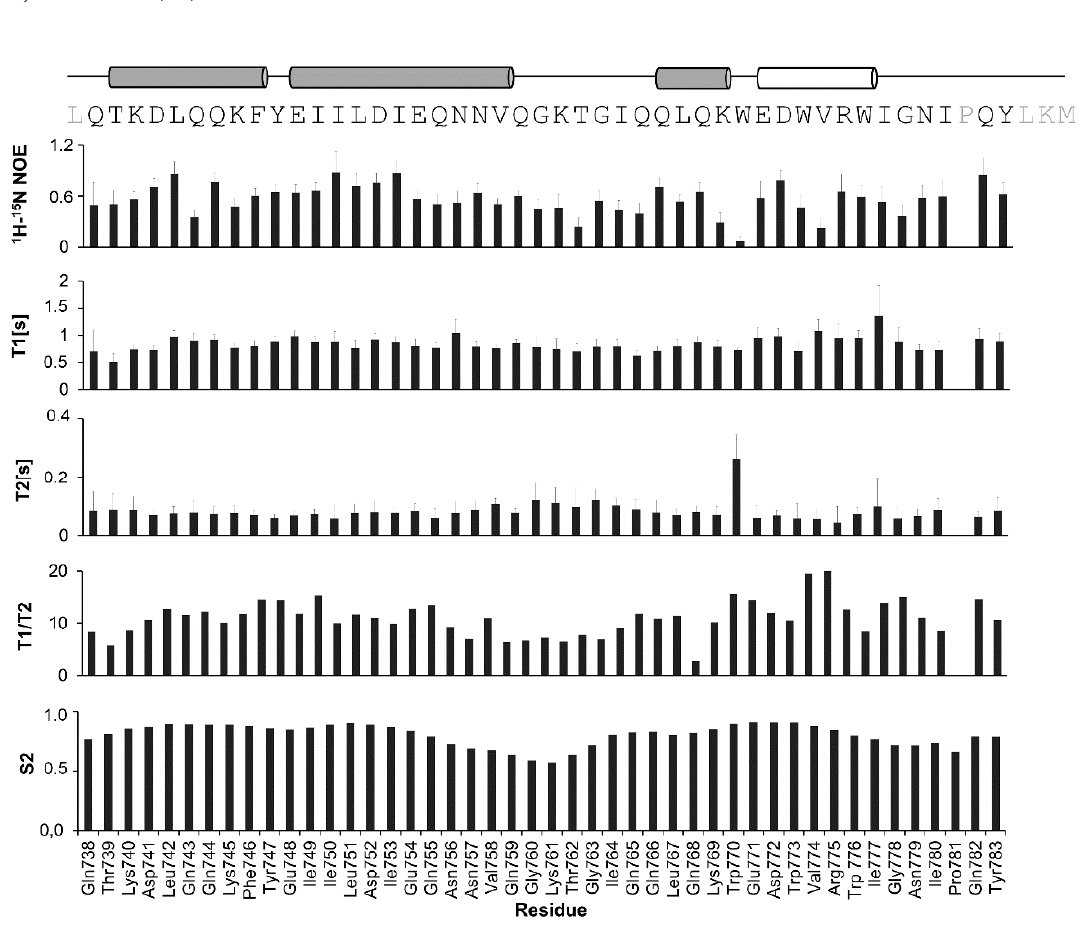
Figure 5. 15 N backbone relaxation measurements for 737-786 gp36 CHR–MPER in DPC / SDS micelles. 1 H- 15 N heteronuclear NOE, T 1, and T 2 experiments were performed on a 600 MHz spectrometer (see Materials and Methods for experimental details). Plot of the T 1 / T 2 ratios obtained from T 1 and T 2 data. Predicted random coil index (RCI) histogram plotted from S 2 values obtained using the TALOS + routine (see Table S1 for data in detail). The α -helices are reported as grey cylinders in the one-letter sequence of 737-786 gp36 CHR–MPER at the top, while the 3 10 helix is reported as a white tube.